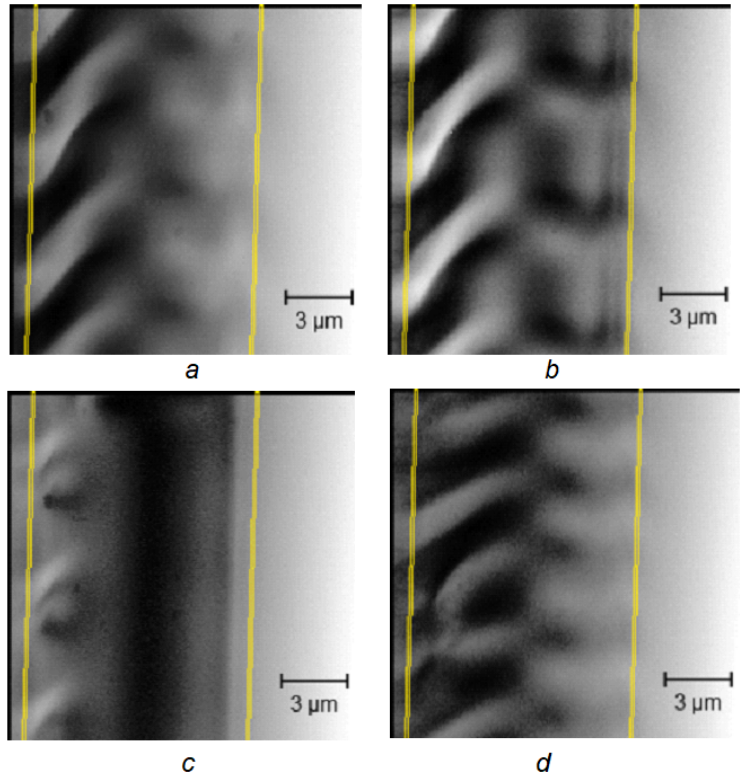
Figure 4. MFM images on a cleavage (end face) of the garnet film in the external out-of-plane magnetic field ( a ) H = 0 Oe, ( b ) H = 190 Oe, ( c ) H = 560 Oe, ( d ) H = 0